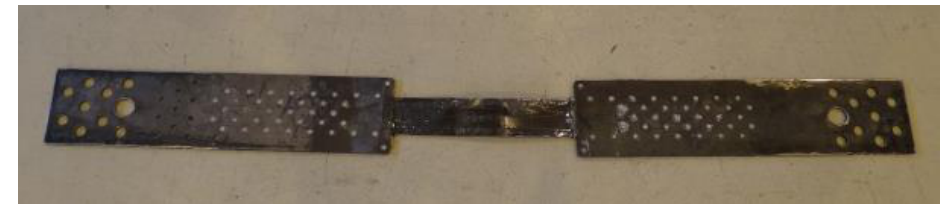
Figure 4. Double-sided N-type anchorage of the NPS I system tested in the S1N–S2N series.